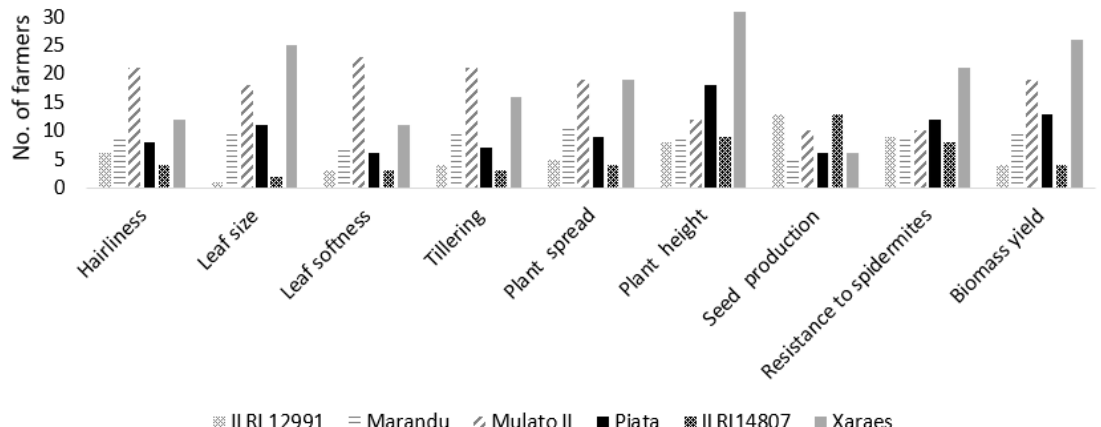
Figure 2. Average number of farmers recorded for the highest score 4 (excellence) for different traits of brachiaria.